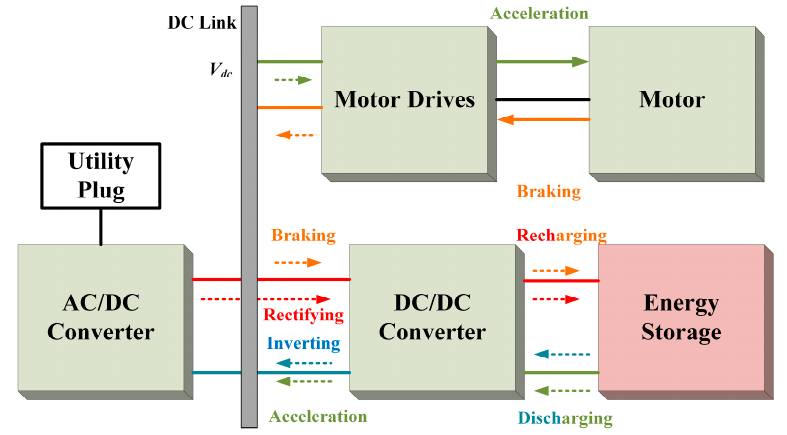
Figure 39. Typical placements of different converters in an EV. AC-DC converter transforms the power from grid to be stored in the storage through another stage of DC-DC conversion. Power is supplied to the motor from the storage through the DC-DC converter and the motor drives [72]. Energies 2017 , 10 , 1217